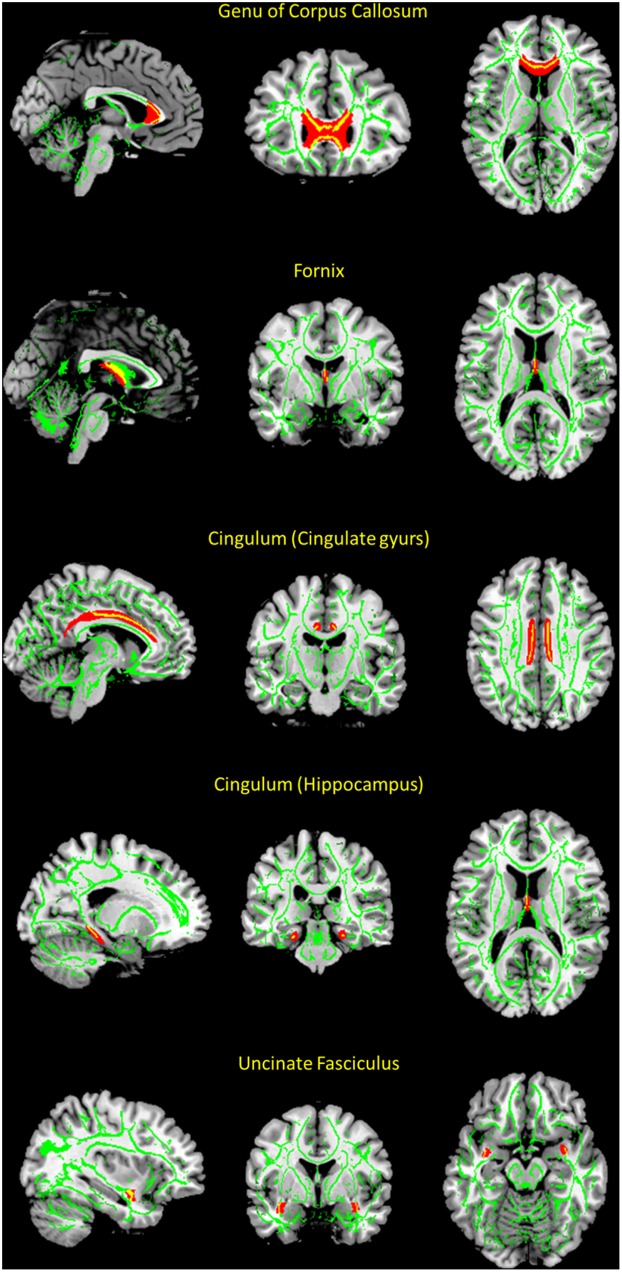
White matter regions of interests (ROIs) from JHU white matter atlas and skeletonized white matter tracts derived from tract-based spatial statics (TBSS).Each ROI within JHU white matter atlas is represented in red color, and each skeletonized white matter tract is represented in green color. Fractional anisotropy values are extracted from the overlapping regions of ROIs within JHU atlas and skeletonized white matter tracts, which are represented in yellow color. (Red color = ROIs within JHU atlas; green color = skeletonized white matter tract; yellow color = overlapping regions of ROIs and skeletonized white matter tracts)